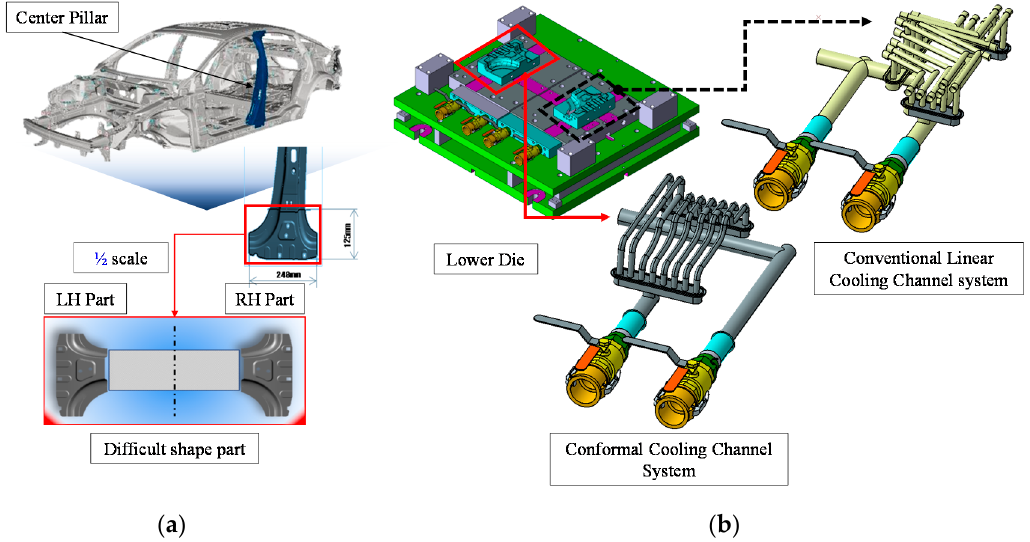
Figure 7. Center pillar shape and die concept for trial forming and evaluation; ( a ) a center pillar part ( b ) die and cooling channel design concept.